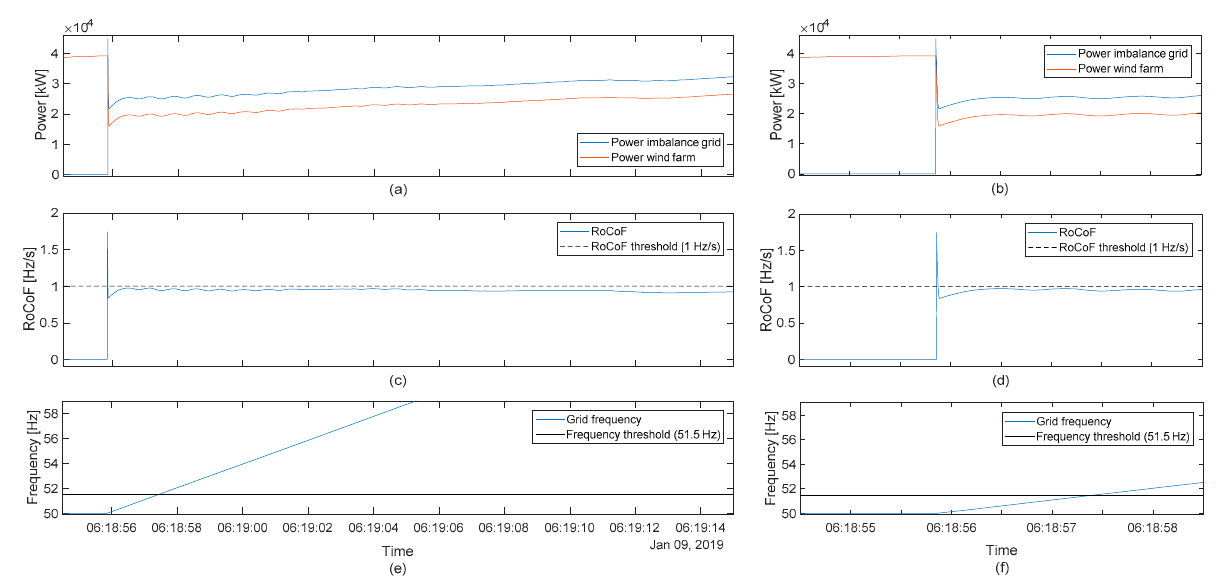
Figure 8. Results of scenario I: Power imbalance in the islanded grid and power of the simulated wind farm for ( a ) the full simulation time and ( b ) a zoom to the time of the event; ( c )/( d ) RoCoF and RoCoF threshold; ( e )/( f ) grid frequency and frequency threshold. Time axes of ( e ) and ( f ) are valid for the above subplots as well.